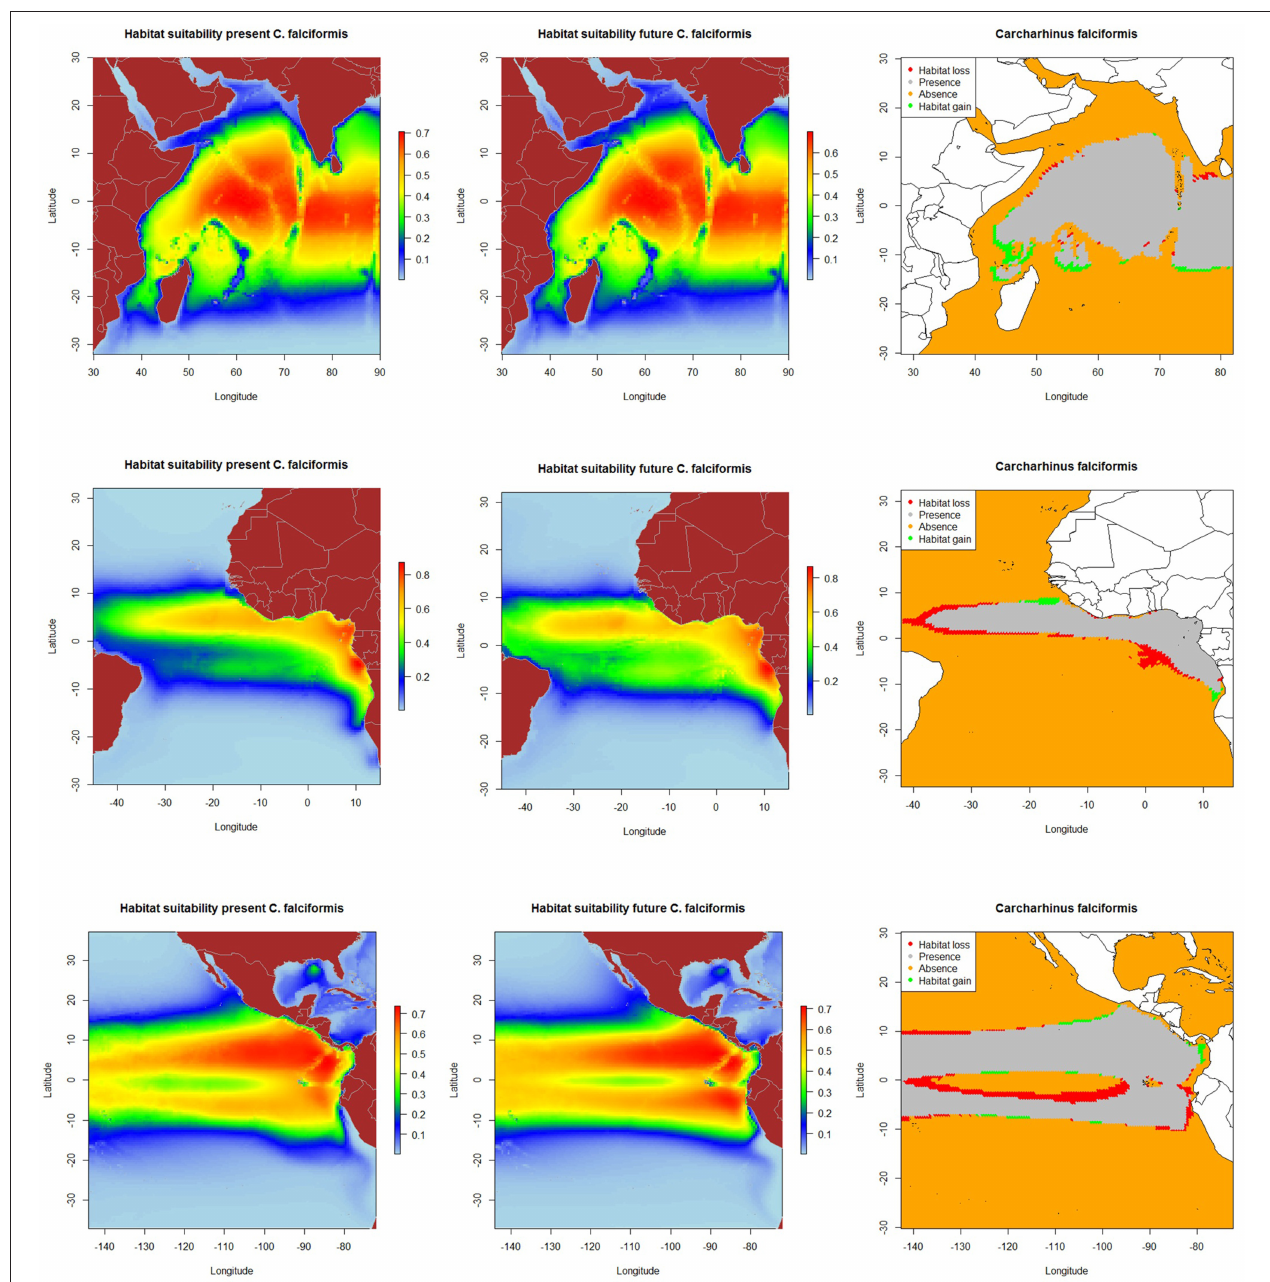
FIGURE 1 | Predicted current conditions (first column), future conditions (second column), and differences between future and present conditions (third column) for habitat suitability areas for Carcharhinus falciformis in the Indian, Atlantic and Eastern Pacific Ocean. The maps (first and second columns) show the probability of occurrence of each species from lowest (blue) to highest value (red).